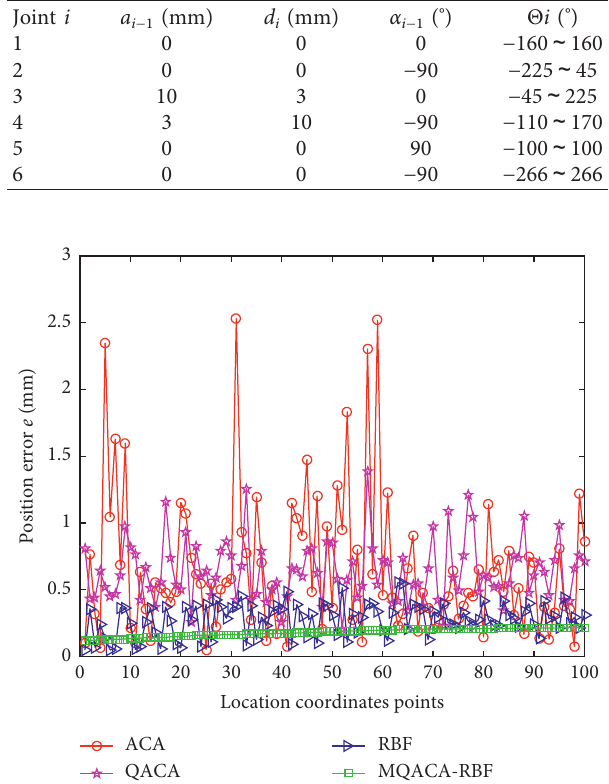
Figure 5: ACA, QACA, RBF, and MQACA-RBF position error